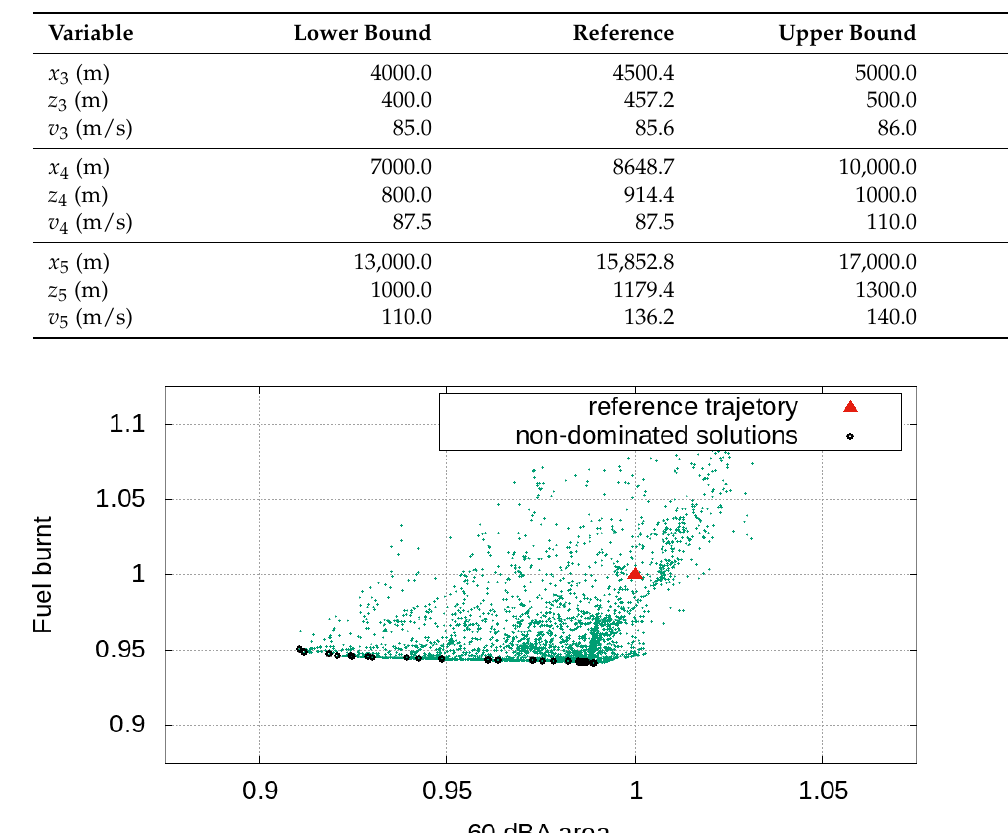
Figure 4. Takeoff manoeuvre for the single-aisle aircraft: normalised DPSO solutions with reference trajectory and approximated Pareto